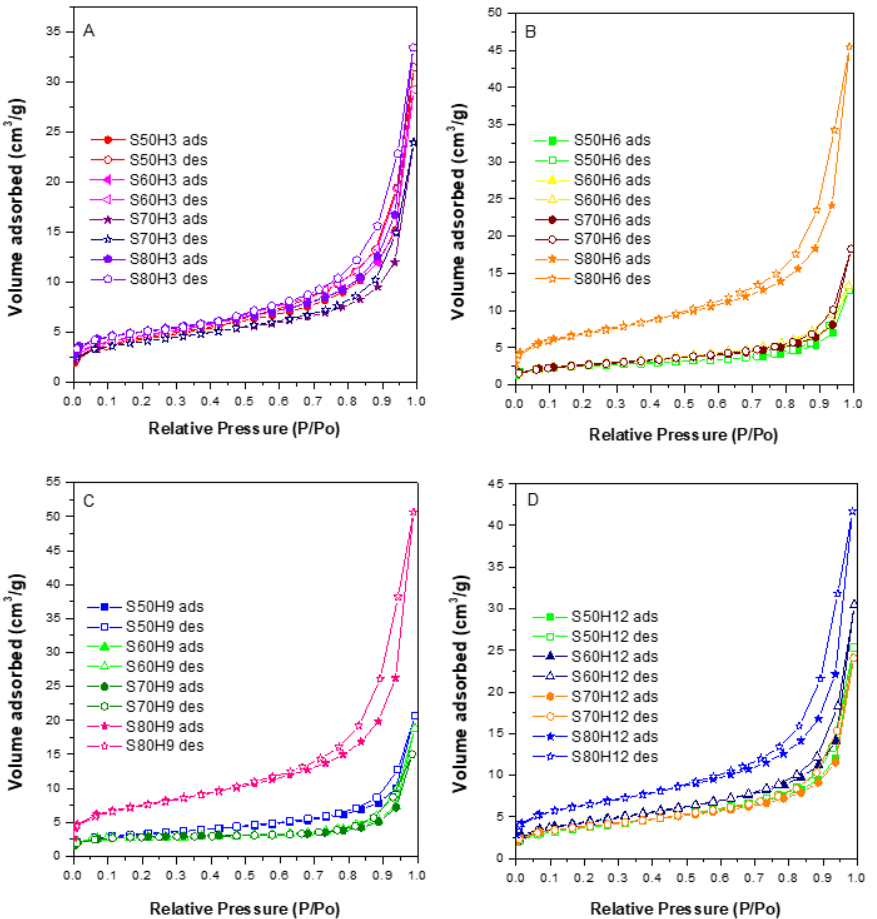
Figure 4. Isotherm of N 2 adsorption-desorption of sodalite sample with the addition of CTABr with time variation of ( A ) 3, ( B ) 6, ( C ) 9, and ( D ) 12 h.